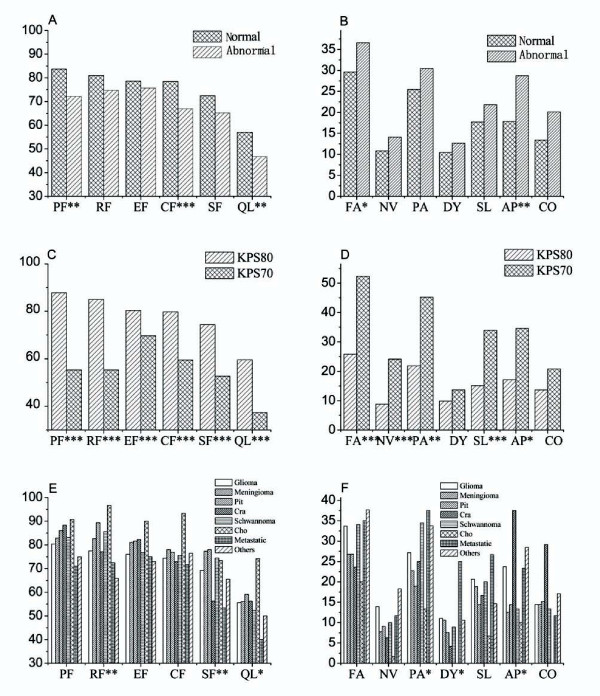
Summary of ANOVA results of QLQ-C30 grouped by preoperative cognition (n = 297), by KPS (n = 266) and by brain tumor types (n = 304). ***. Correlation is significant at the .001 level (2-tailed). **. Correlation is significant at the .01 level (2-tailed). *. Correlation is significant at the .05 level (2-tailed). Abbreviations: AP appetite loss, CF cognitive functioning; Cho cholesteatoma; CO constipation; Cra craniopharyngioma; DI diarrhea; DY dyspnea; Abnormal abnormal cognition; EF emotional functioning; FA fatigue; FI financial difficulties; KPS70 KPS ≤ 70; KPS80 KPS ≥ 80; NV nausea/vomiting; Normal normal cognition; PA pain; Pit pituitary adenoma; QL global health status/quality of life; SF social functioning; SL insomnia